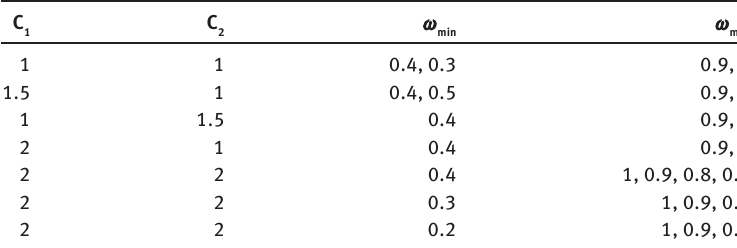
Table 2: Simulation Setups for PSO Parameters.